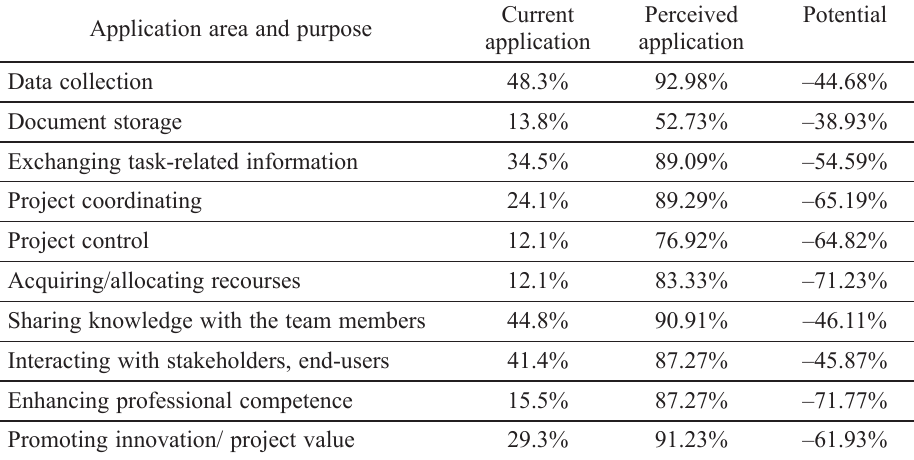
Table 1. Actual and perceived application of social media tools in project communication